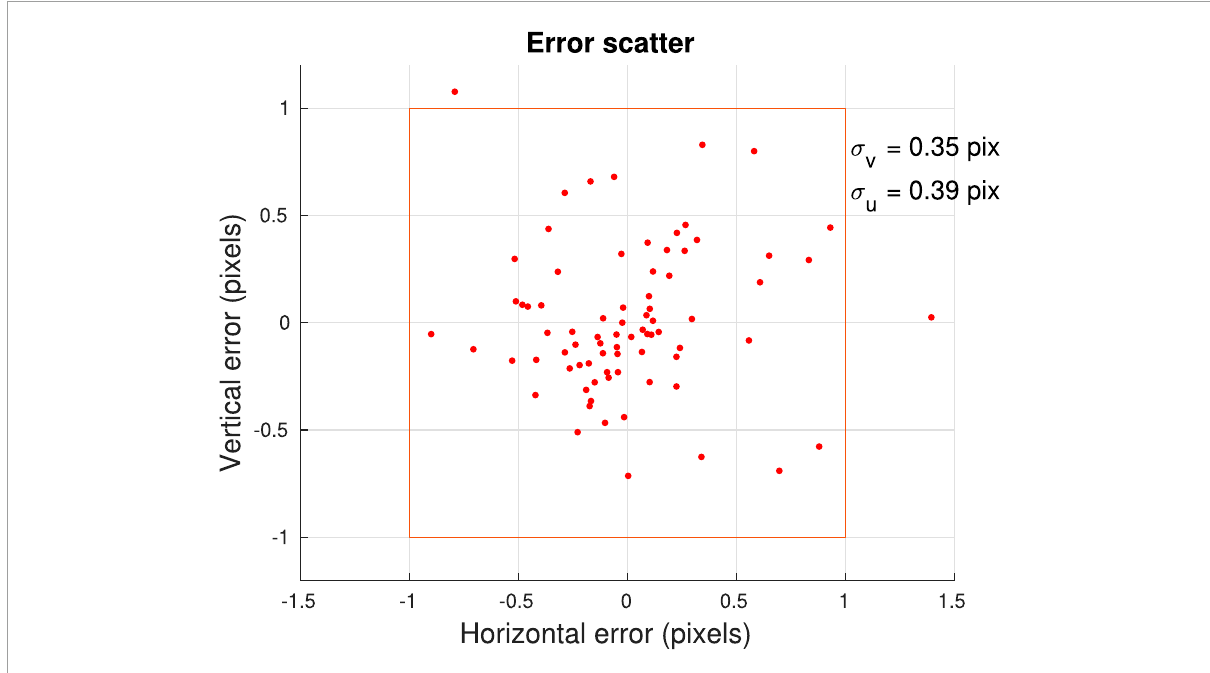
FIGURE 4 Position residuals for calibration sources in the Skibotn camera in units of pixels in the horizontal and vertical direction.